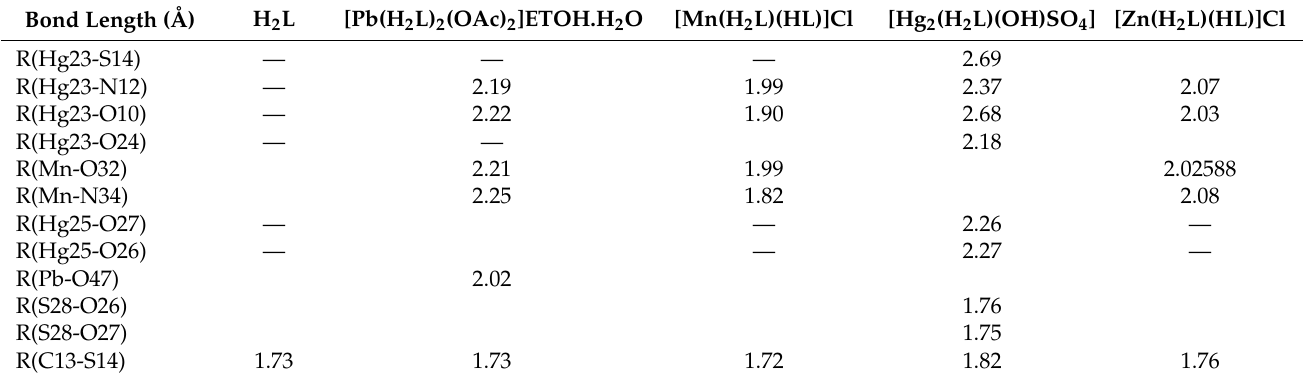
Table 7. Some of the optimized bond lengths (Å) and bond angles (degrees) for H 2 L and the complexes using B3LYP/6-311G. Bond Length